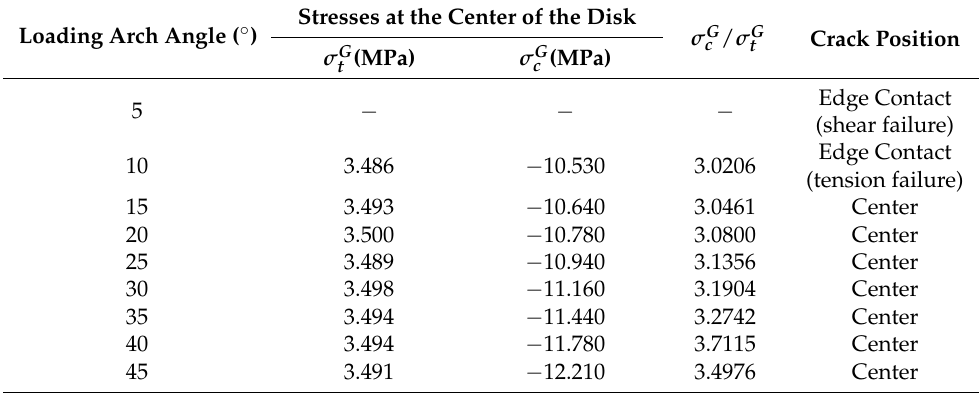
Table 5. Predicted stresses at the center of disk of mortar tested by [8] and the initial position of the